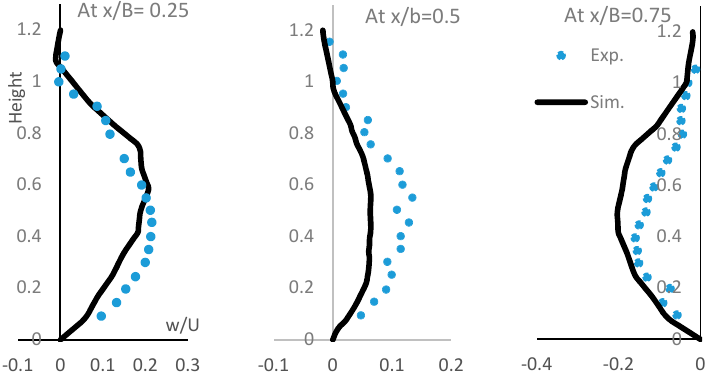
Figure 17. A comparison between the measurements and numerical results of the normalized vertical velocity profile (w/U) at the leeward x/B = 0.25, center x/B = 0.5 and windward x/B = 0.75.